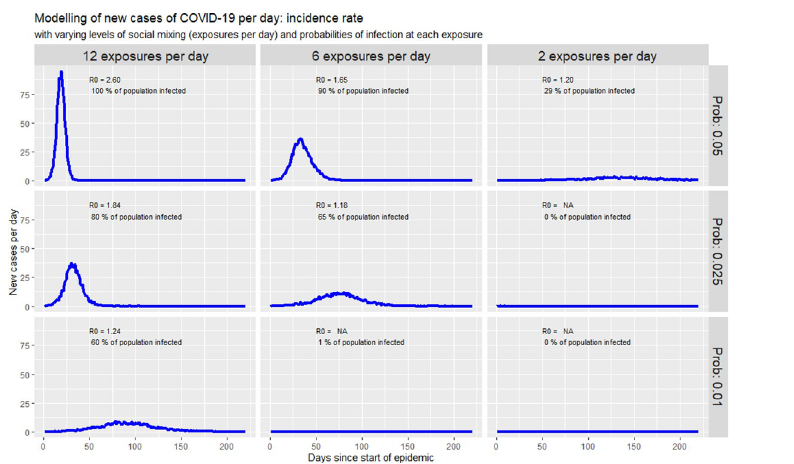
Fig 8. Simulating new cases of COVID-19 with public health